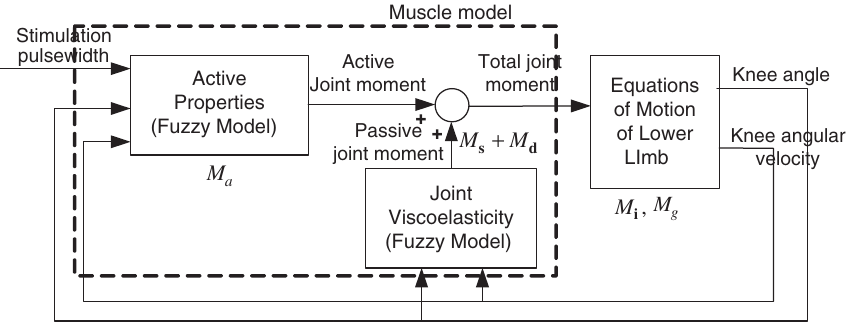
Fig. 1. Schematic representation of the knee joint